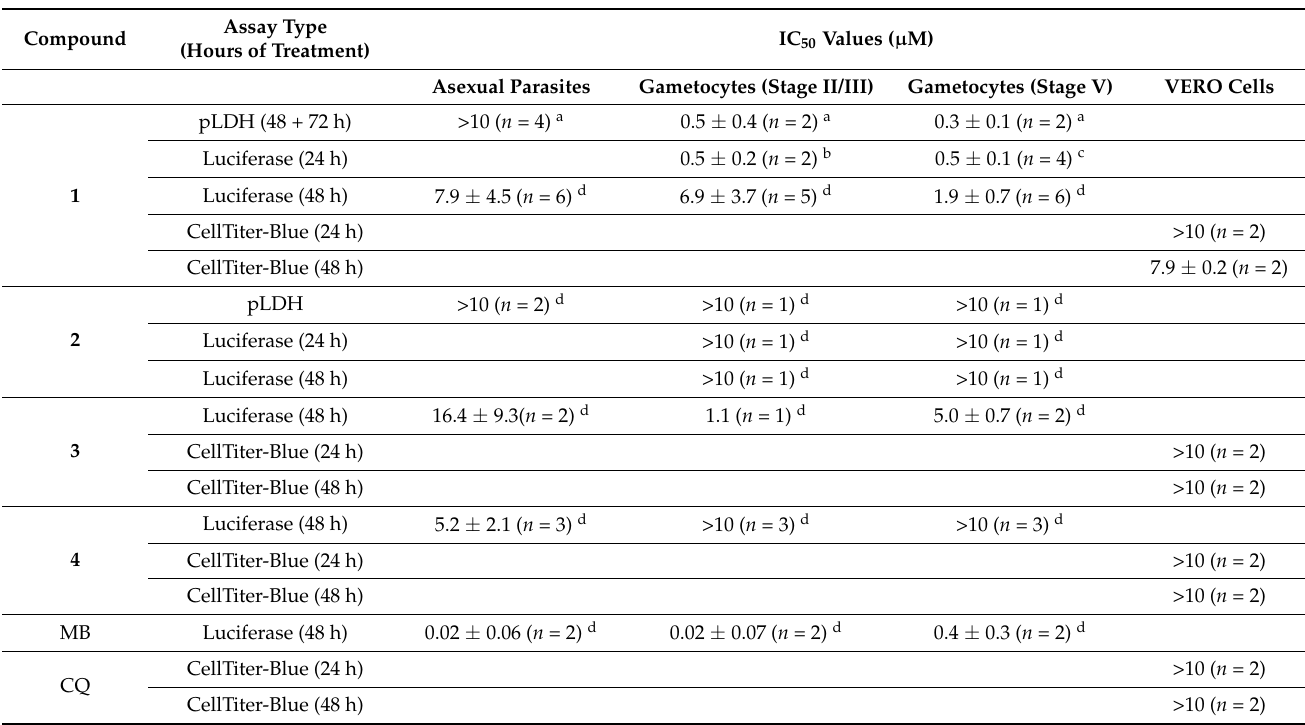
Table 1. IC 50 values (µM) of 1 , 2 , 3 , and 4 and Methylene blue (MB) on P. falciparum asexual and sexual stages measured in luciferase and pLDH assays. IC 50 values (µM) of compounds 1 , 3 , 4 , and chloroquine (CQ) on Vero cells measured in CellTiter-Blue assays.